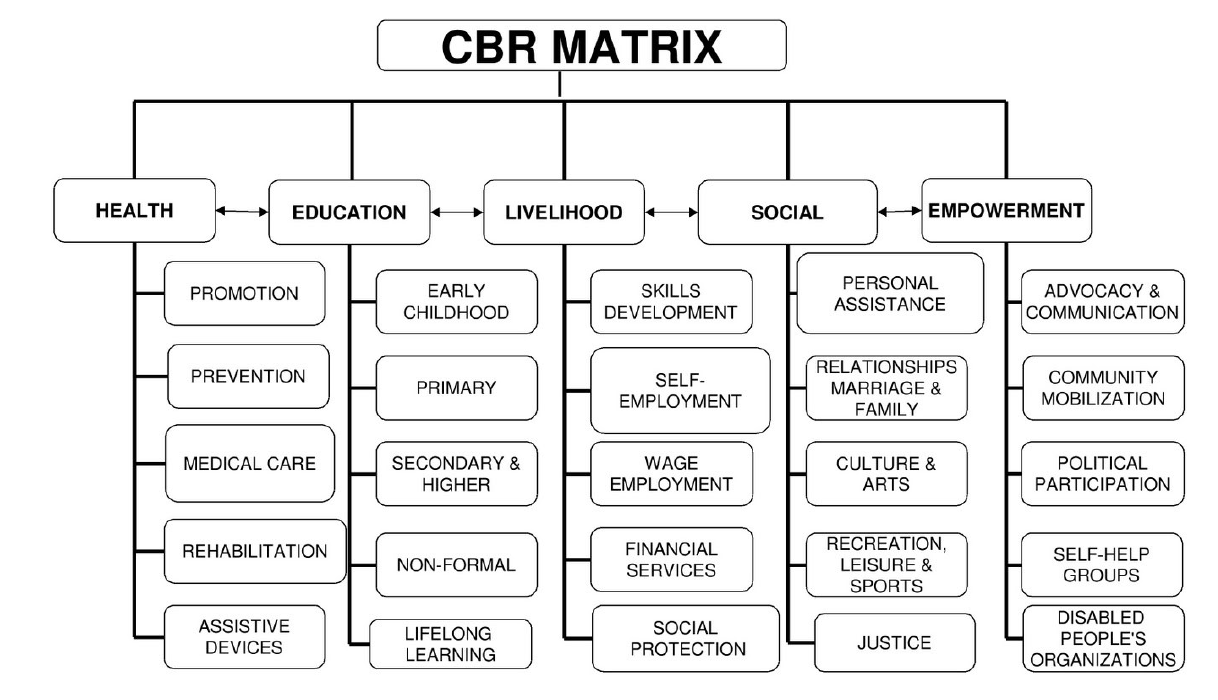
Figure 2. Community based rehabilitation matrix.